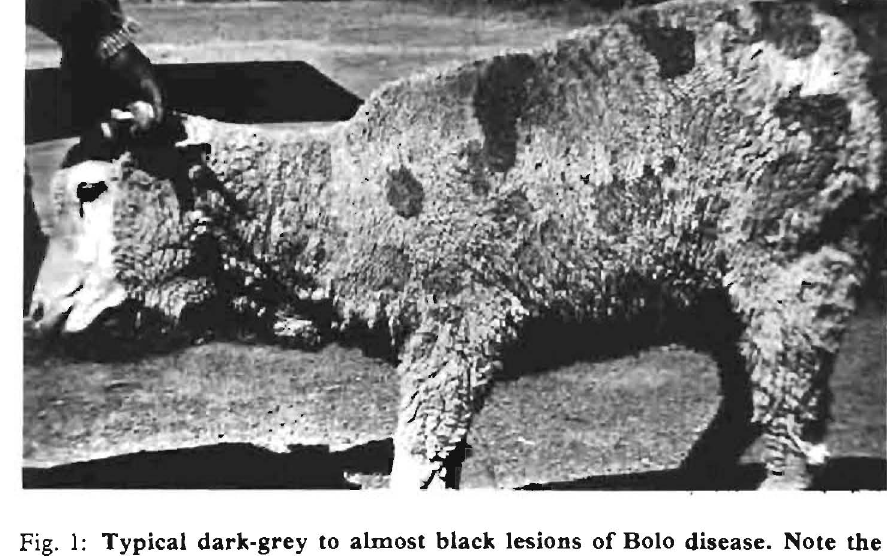
Fig. 1: Typical dark-grey to almost black lesions of Bolo disease. Note the depressed surface of the fleece in these areas